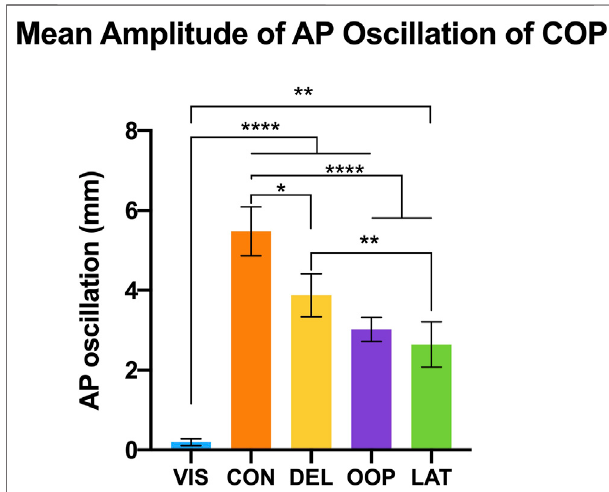
FIGURE 8 | Mean ( N (cid:2) 30 participants), and 95% interval limits, amplitude of anteroposterior displacements of the centre of pressure for each condition. VIS, Visual-only condition (no vibration); CON, congruent condition; DEL, delayed condition; OOP, out-of-phase condition; LAT, lateralized condition.*Indicatesstatisticalsigni fi cancewith p < 0.05,**indicatesstatistical signi fi cance with p < 0.01 and **** indicates statistical signi fi cance with p <